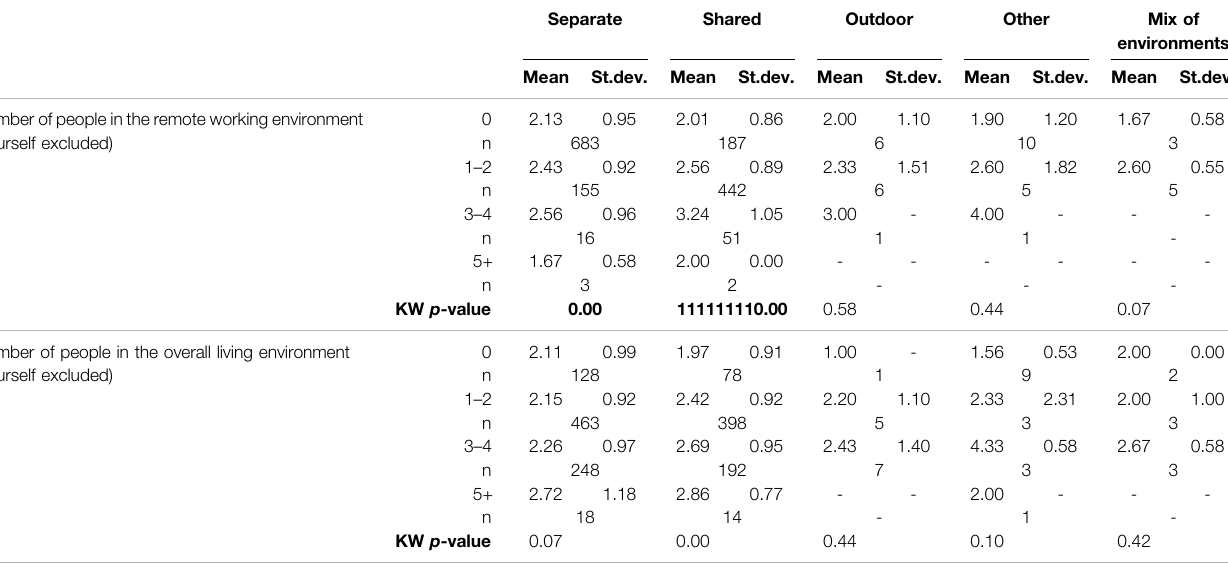
TABLE 11| Mean and standarddeviation (St.dev.) valuesof theanswers given by sensitive tonoiserespondents ( n (cid:1) 1,576)on noise annoyance (Q1) related tothenumber of people in the remote working environment and in the overall living environment. Two-tailed p -values of signi fi cance of the differences according to the Kruskal Wallis (KW) Test are reported. Statistically signi fi cant differences with p -values < 0.05 are reported in